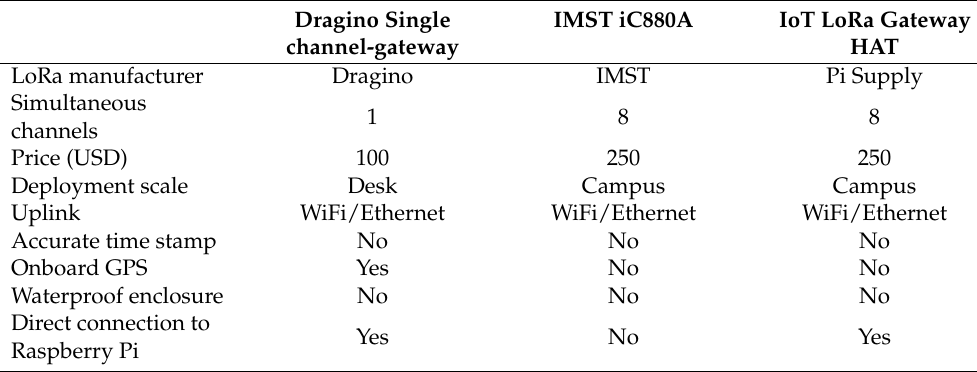
Table 3. Comparison of different Raspberry Pi LoRaWAN gateway solutions. Prices are correct as of December 2019 and exclude suitable external antenna, mounting hardware, and power